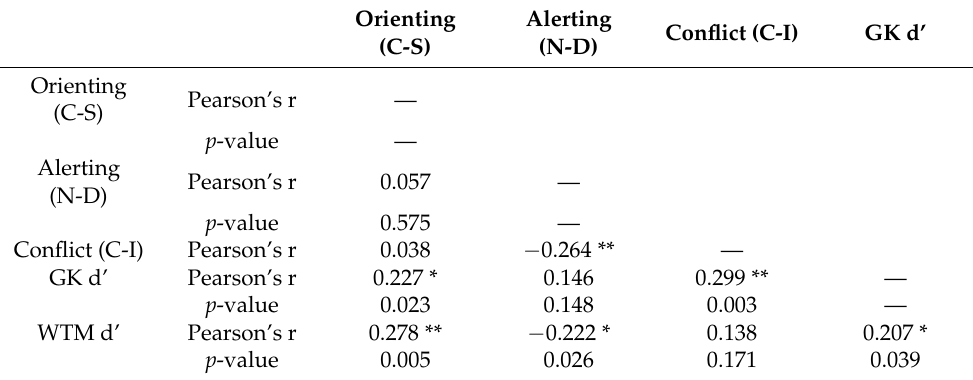
Table 2. Correlations among the three networks of attention, the d’ for the VR Goalkeeper task, and the d’ for the Whack-a-Mole